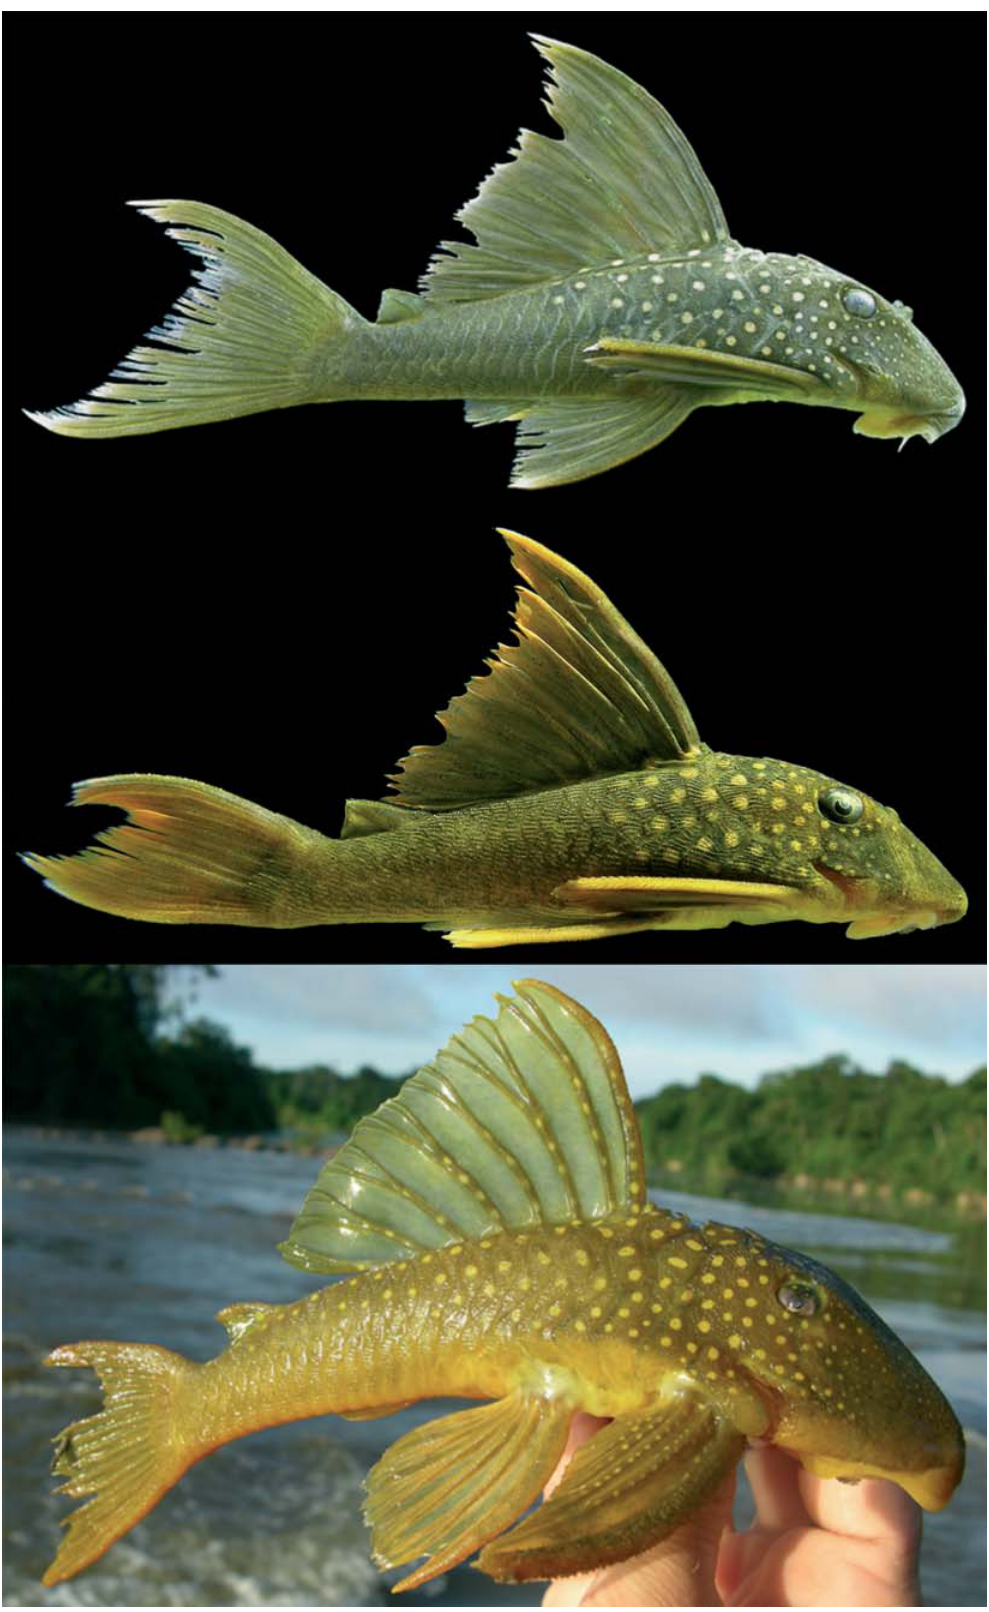
Fig. 1. Live specimens of a: Baryancistrus demantoides , adult, AUM 42034, paratype, 96.3 mm SL; b: B. demantoides , juvenile, MCNG 54031, paratype, 54.1 mm SL; c: Hemiancistrus subviridis , AUM 42933, 146.9 mm SL. Photos by M.H.